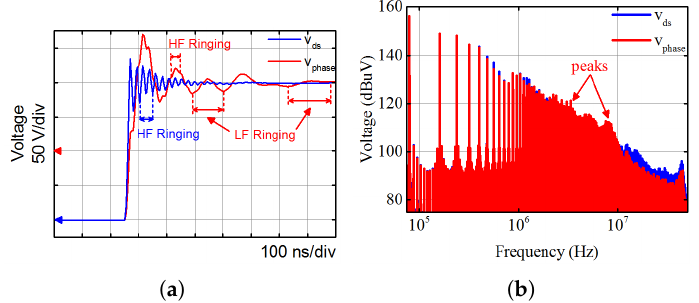
Figure 17. Comparison between calculated v ds and v phase : ( a ) Time-domain waveforms, ( b ) Spectra.